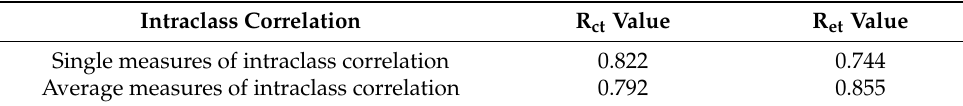
Table 2. The intraclass correlation coefficients obtained by reliability analysis.